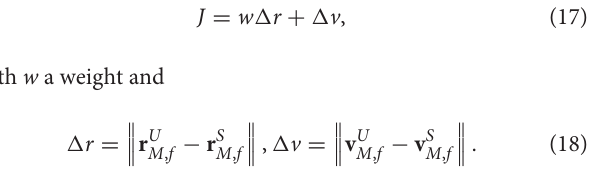
Frontiers in Applied Mathematics and Statistics |